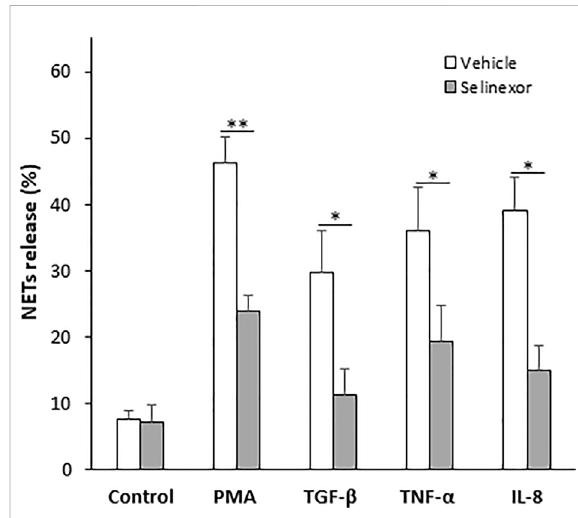
Selinexor inhibits NETs formation induced by various stimulators of neutrophils. Different activators, including 20 ng/ml TGF- β ( N = 5), 20 ng/ml TNF- α ( N = 5) and 20 ng/ml IL-8 ( N = 5) induced NETs release compared to positive control using 100 nM PMA ( N = 8). Neutrophils incubated without an inducer were used as negative control ( N = 8). Incubation with Selinexor inhibited NETs release by the inducers in a different extent. In case of PMA the inhibitory effect was 48.5% and statistically signi fi cant ( p < 0.01). In case of TGF- β , TNF- α and IL-8 selinexor ’ s inhibitory effect was 61.6%, 46.4%, and 61.3% respectively ( p < 0.05).